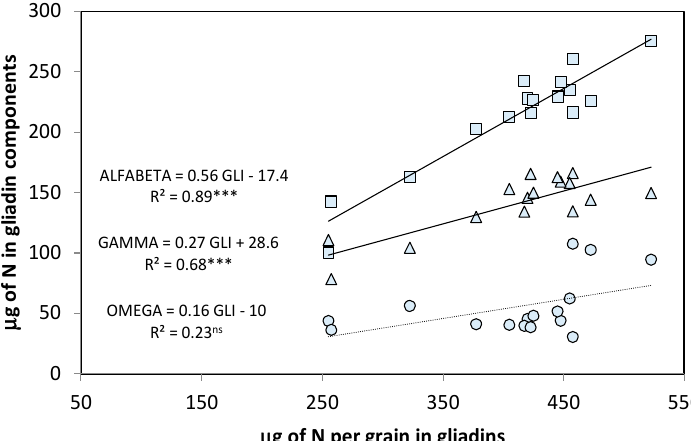
Figure 3. Relationships between the variation in the µg of total gliadins per grain and the content of the three gliadin components: alpha/beta (squares), gamma (triangles), and omega (circles). Points are cultivars means across years and N treatments. ***, p ≤ 0.001; ns, not significant. The S-rich LMW-GS were present in larger amounts than the S-poor HMW-GS (Figure 4) and showed greater genotypic variation: 270–510 µg grain − 1 (coefficient of variation = 36 vs. 19% for HMW-GS). The genotypic variation in grain N allocated to glutenins was more tightly associated with the variation in LMW-GS ( R 2 = 0.93 ***) than in HMW-GS ( R 2 = 0.47 **).